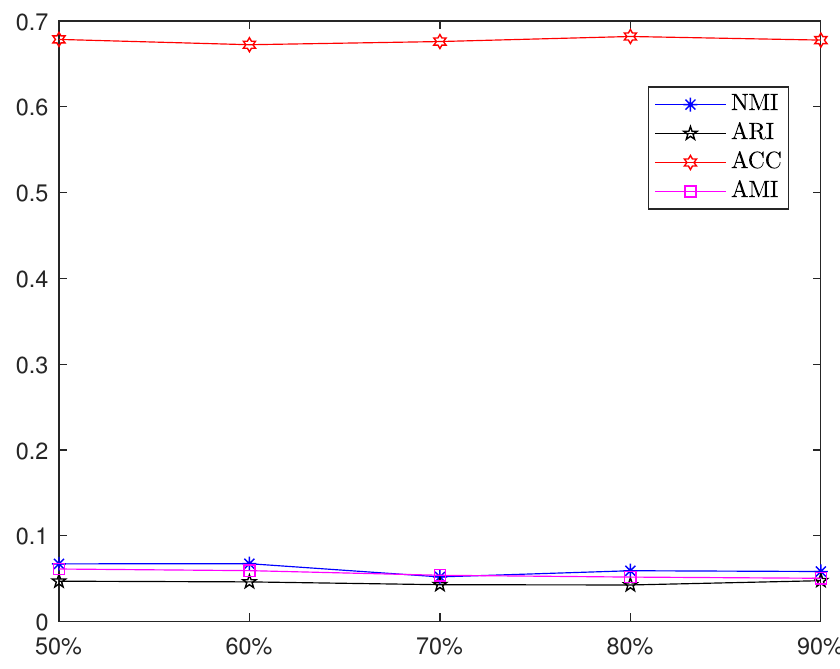
Figure 7. Results of Musk recognition by